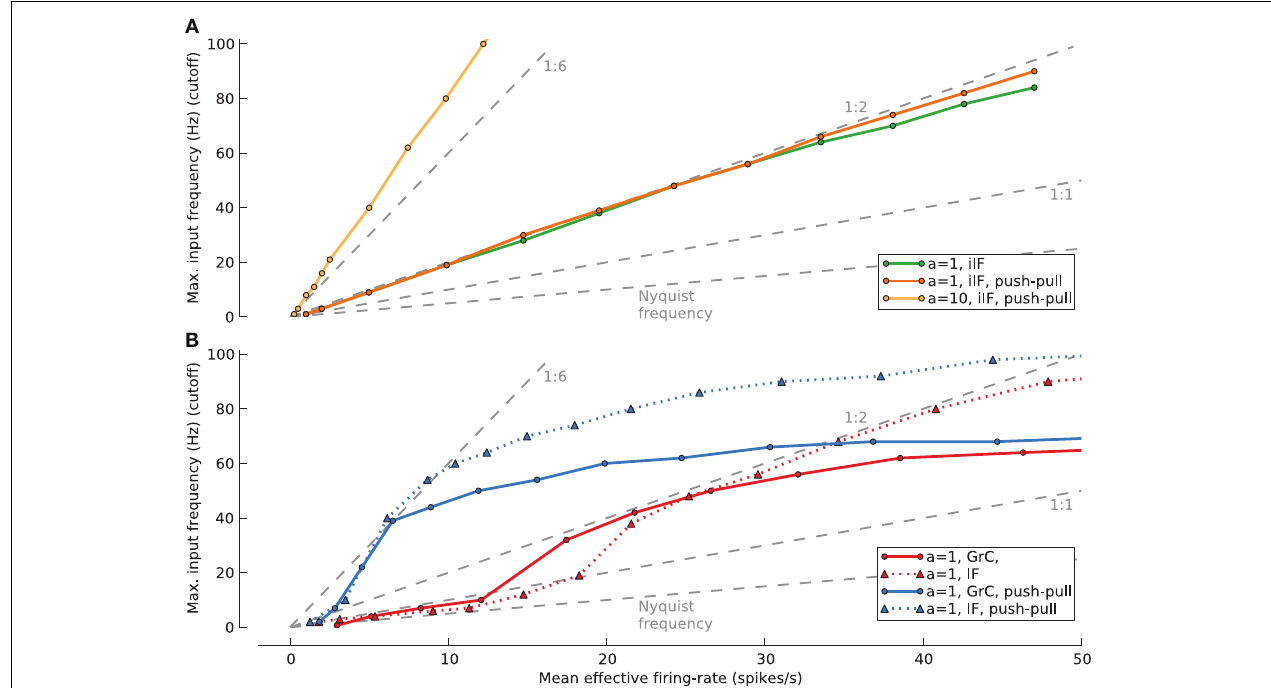
FIGURE 10 | Signal with maximum input frequency (cutoff) that can be transmitted with a mean reconstruction quality VAF > 90% for populations of N = 100 under different firing-rates ( F eff ). (A) Results for ideal IF cell (iIF) (green line/circles: a = 1; orange line/circles: a = 1, push-pull coding; light orange line/circles: a = 10, push-pull coding). (B) Results for synaptically stimulated GrC